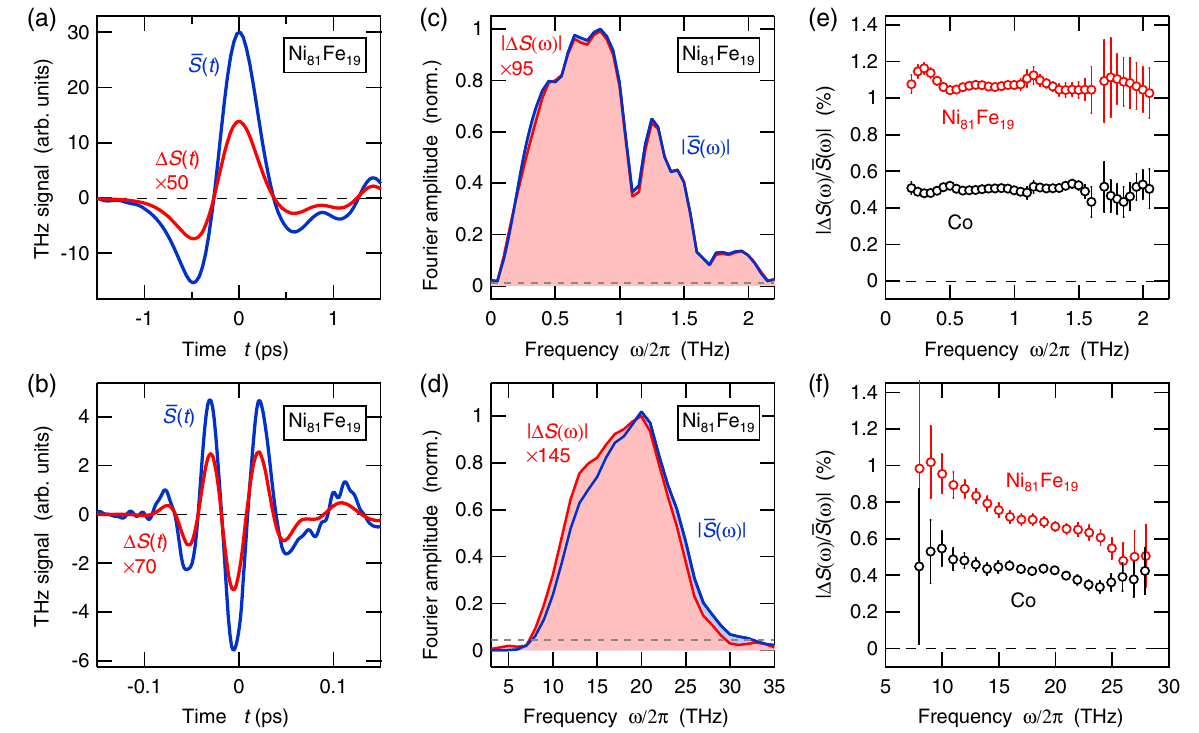
¯ S ð t Þ ¼ ¯ S ð ω Þj of the traces of panels (a) and (b), respectively. Signals ¯ S ð ω Þj as derived from panels (c) and (d), respectively (red ¯ S ð ω Þj is closely related to the AMR contrast through Eq. (6).